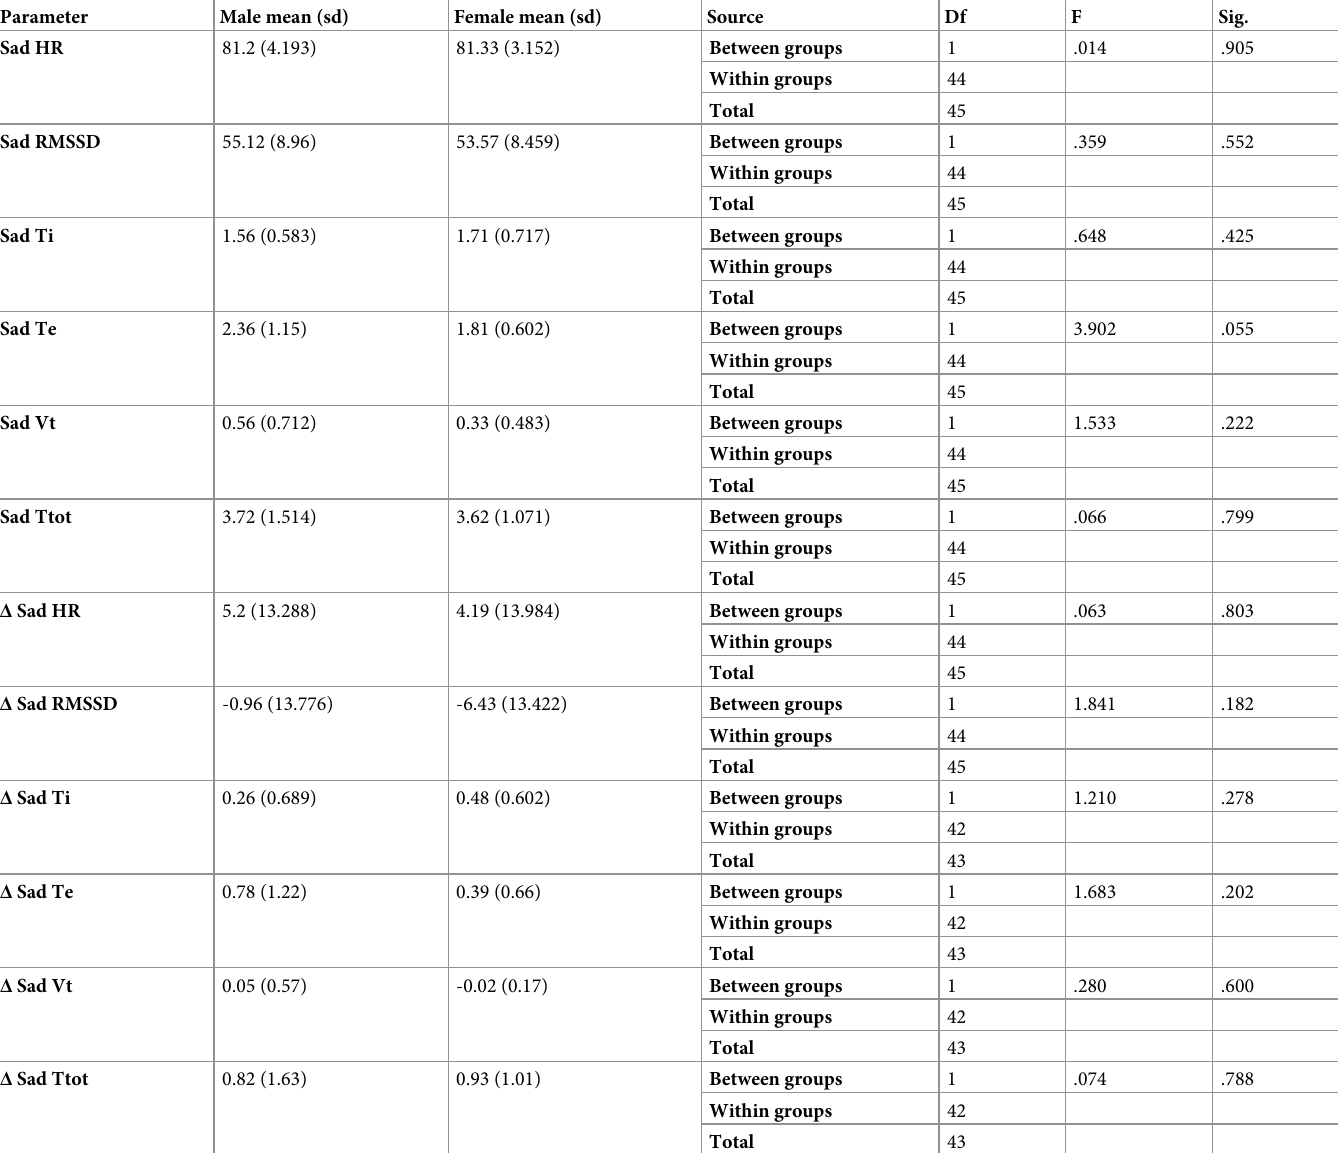
Table 6. ANOVA for autonomic (cardiac and respiratory) response and reactivity during sadness of males and females. Parameter